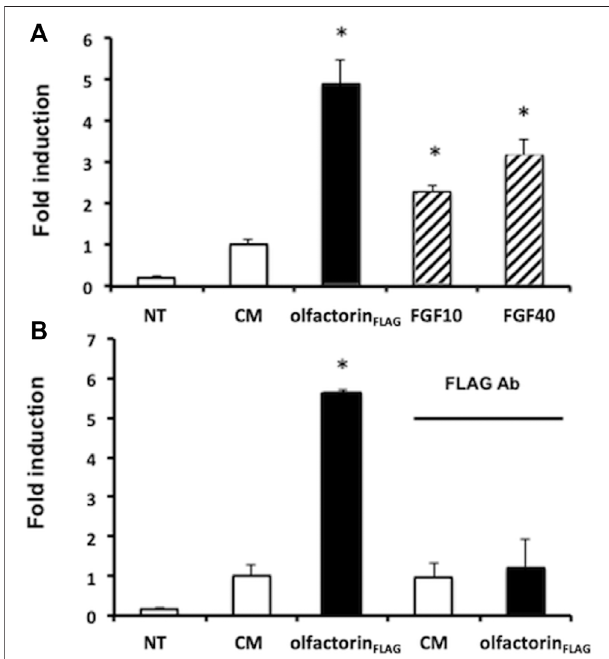
FIGURE 6 | Transcriptional analysis of olfactorin effects on GN11 cells. (A) GN11 neurons were transfected with OSE luciferase reporter and then exposed 24 h to increasing doses of FGF2 (at 10 and 40 ng), used as internal assay control, to the control CM and to olfactorin FLAG . (B) Immunoneutralization of the olfactorin FLAG by preincubation with the anti- FLAG antibody. All treatments were done in triplicate, with cultures repeated three times in total; NT and control untreated cells. Data are presented as fold induction vs. CM (mean ± SD, n. 4). * p < 0.05 vs NT; ** p < 0.05 vs CM.